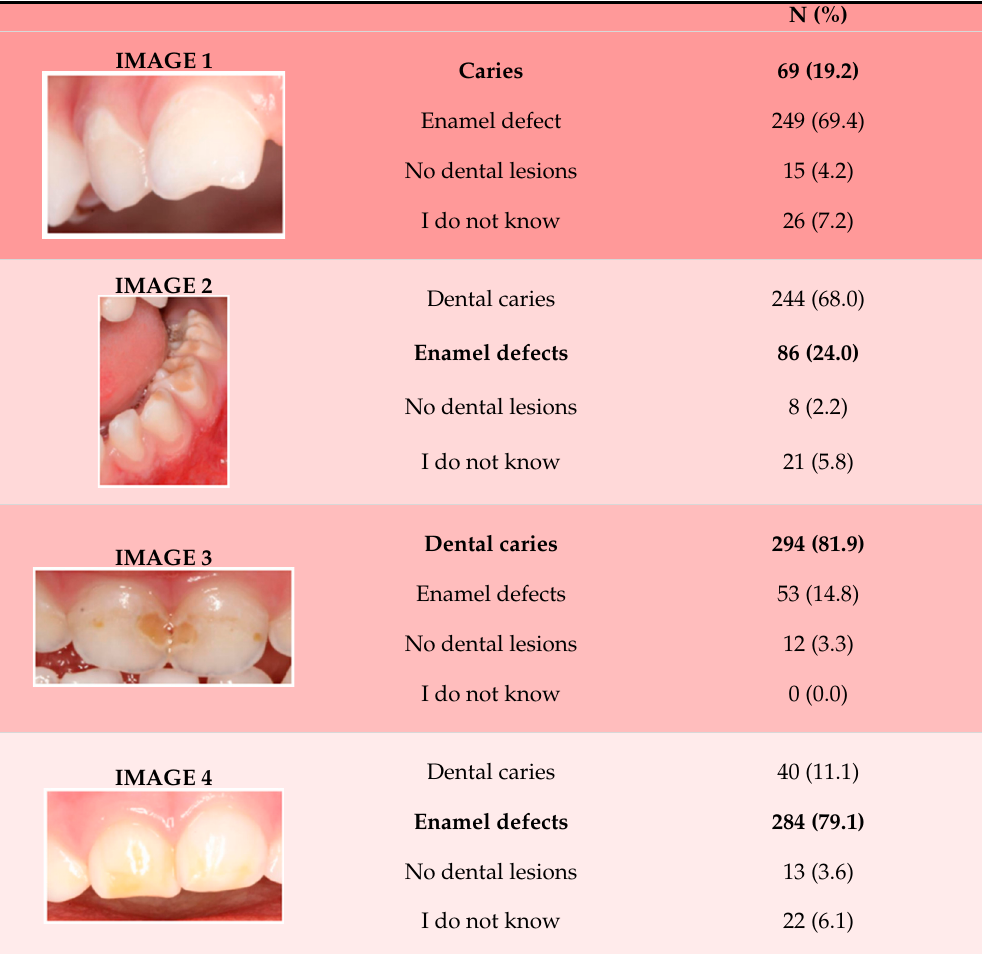
Table 5. Identification of lesions by clinical imaging.